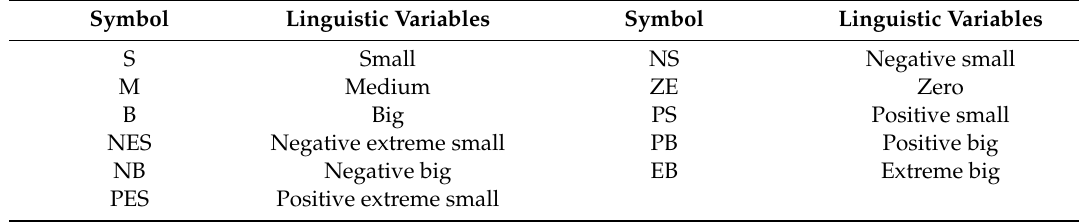
Table 3. Fuzzy linguistic variables